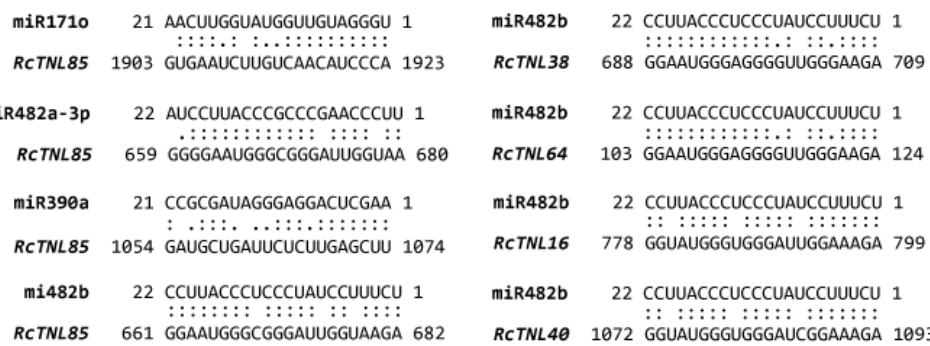
Figure 5. Possible microRNA binding sites for five RcTNL genes. Double dots between bases indicate a successful pairing, single dot indicates an additional pairing between U and G, and a blank indicates no pairing.